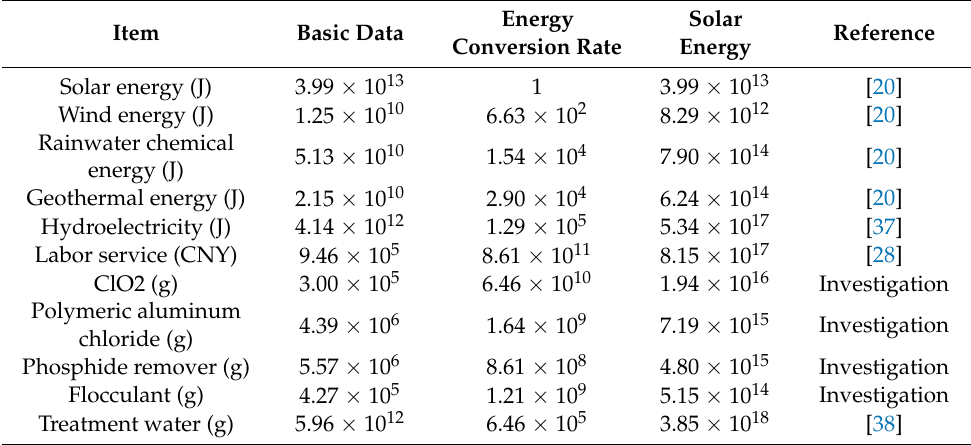
Table 2. ABR + CASS process energy analysis table.